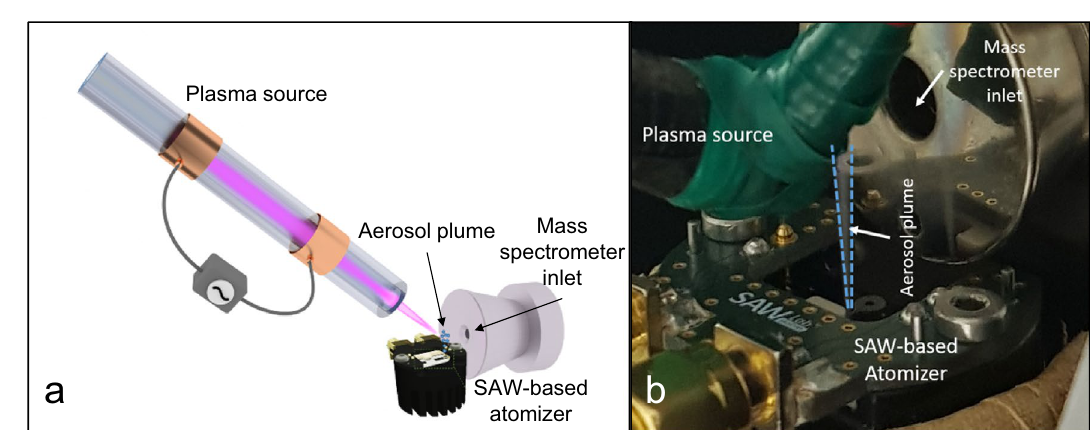
Figure 4. Scheme ( a ) and photograph ( b ) of the experimental setup for SAW-assisted